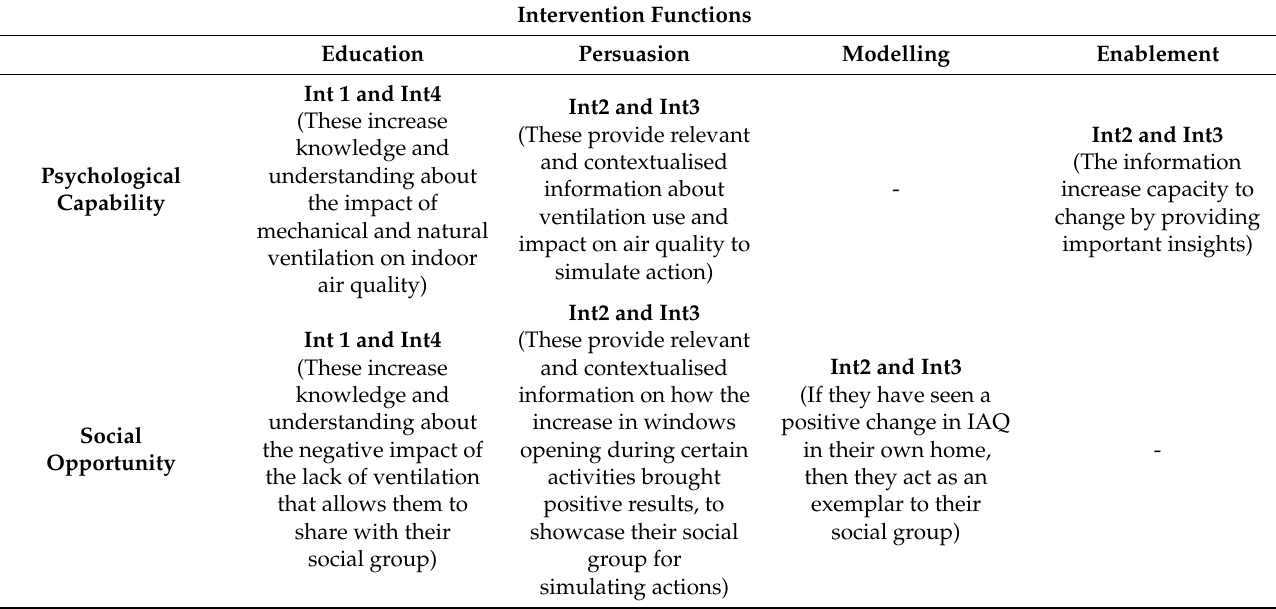
Table 5. COM-B model elements help to design interventions for indoor ventilation, which can help to reduce